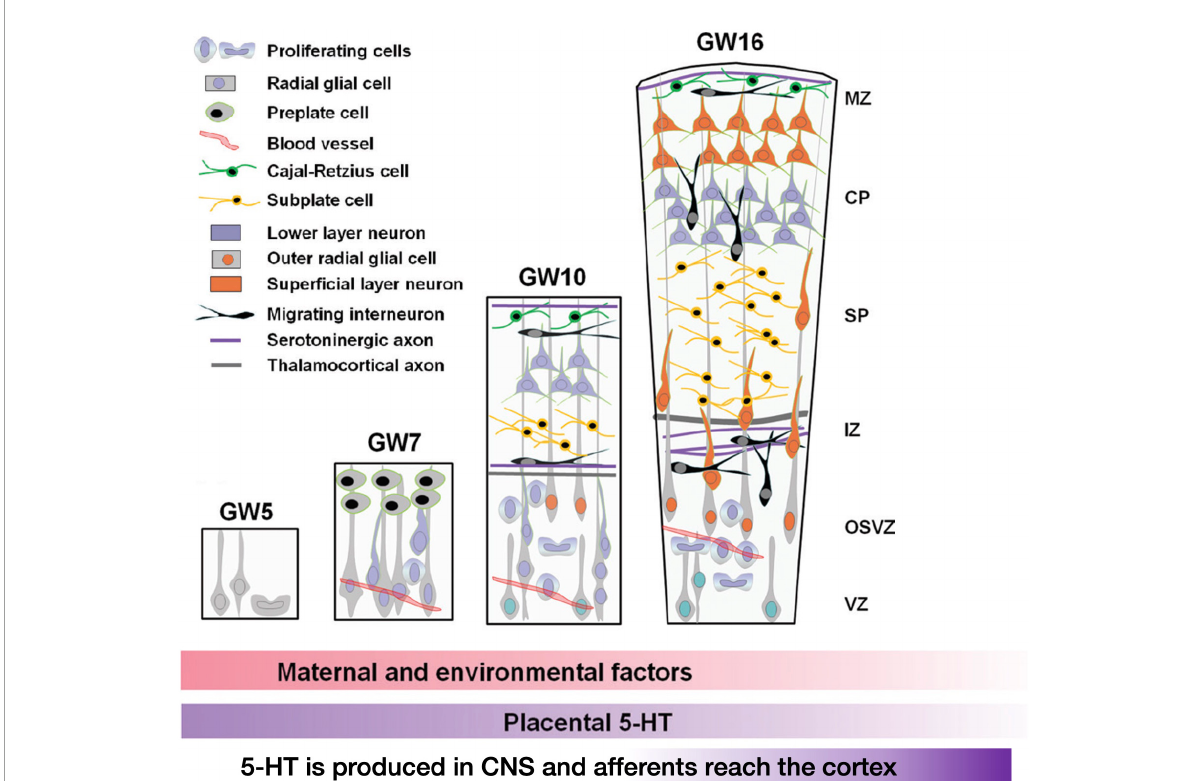
FIGURE6 Early stages of development of the human cerebral cortex in relation with 5-HT afferents. In human, intense proliferation of the neuroepithelium and formation of the preplate (PP) take place around GW5 and GW6–7, respectively. By GW8–10, PP is split by the migration of the first pyramidal neurons. Cajal-Retzius cells (C-R) will remain in the marginal zone (MZ, presumptive layer I) while sub-plate neurons (SP) will be positioned below the cortical plate (CP). In addition, around GW10, another source of progenitors arises: the outer radial glial (oRG) cells that do not maintain contacts with the apical surface. Monoaminergic axons and thalamo-cortical axons (TC) are already found in the MZ and in the intermediate zone (IZ), respectively. By GW16, SP cells occupy a large proportion of the cortical anlage and oRG are still producing a high number of neurons. Interneurons migrating first tangentially and later radially to the pial surface, incorporate into the CP. The cortical structure is vascularized very early and carries platelets and mast cells that could provide 5-HT to the developing embryo. During the initial phase of cortical development, 5-HT is mainly synthesized in the placenta while later produced by serotonergic neurons of the embryo. The colored lower bars indicate the times at which different factors (maternal and environmental; 5-HT of placental origin, 5-HT produced by the embryo itself) could affect the development (figure from Vitalis and Verney, 2017), obtained by Elsevier (No. 5410821023270) under a creative commons license